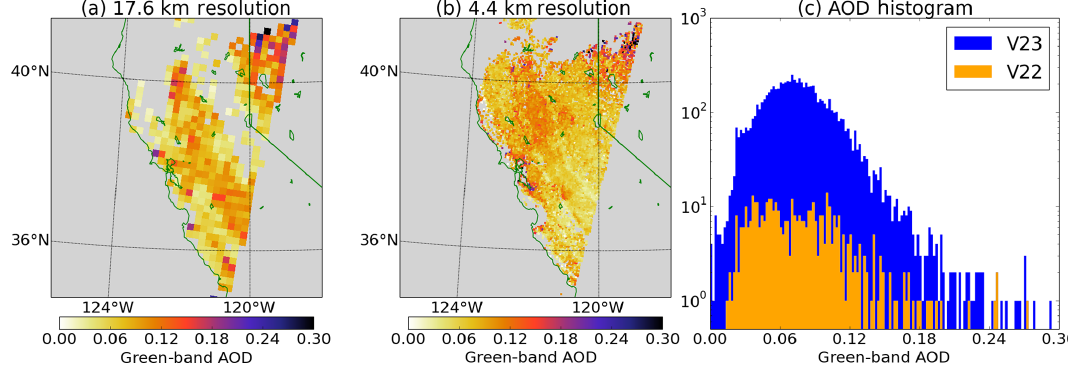
Figure 5. Comparison of V22 and V23 AOD retrievals for 5 July 2016 (orbit 88022): (a) V22 AOD map, (b) V23 AOD map, (c) AOD